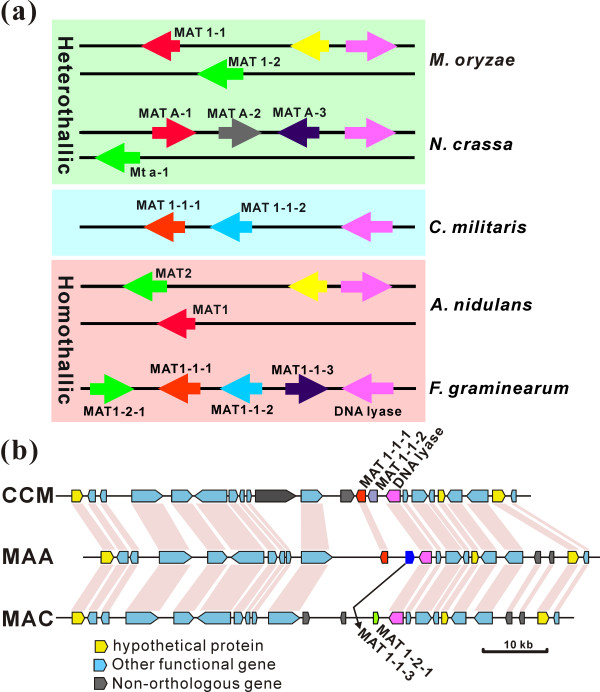
Comparative analysis of the C. militaris mating-type (MAT) locus. (a) Comparative analysis of the C. militaris MAT locus with those of sexually heterothallic and homothallic fungal species. Genes labeled in the same color have orthologous relationships. (b) Syntenic relationship of the MAT loci and their flanking regions between the three insect pathogens C. militaris (CCM), M. anisopliae (MAA) and M. acridum (MAC).